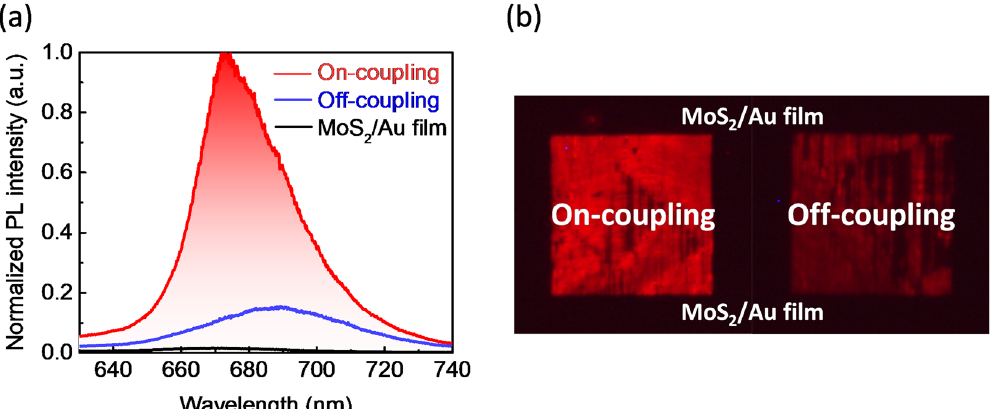
Fig. 5 PL properties of intermediate coupling systems. a Normalized PL spectra. b PL images of the MoS 2 /Au fi lms, on-coupling sample (MoS 2 /NG3), and off-coupling sample (MoS 2 / NG7), respectively.